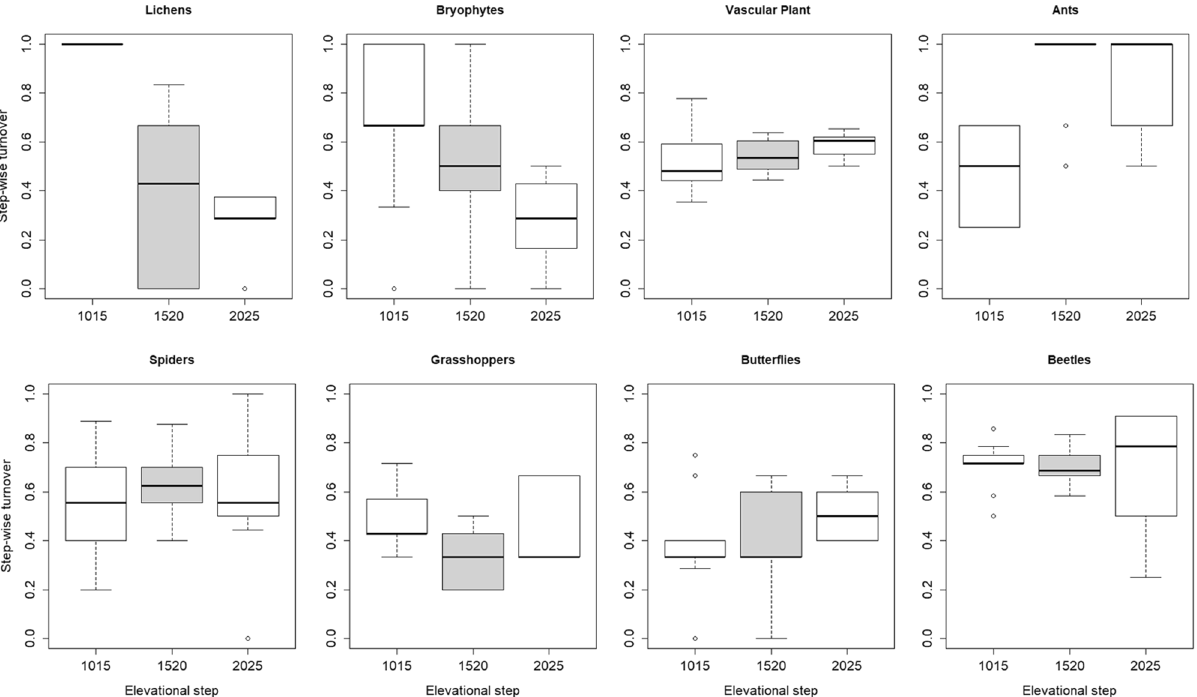
Figure 5. Step-wise turnover (pair-wise comparisons) of neighboring steps. 1,015… comparison of steps 1,000 and 1,500, 1,520… comparison of steps 1,500 and 2,000, 2,025… comparison of steps 2,000 and 2,500. Figure was produced using R software (version 3.6.2, R Core Team, https ://www.r-proje ct.org/).